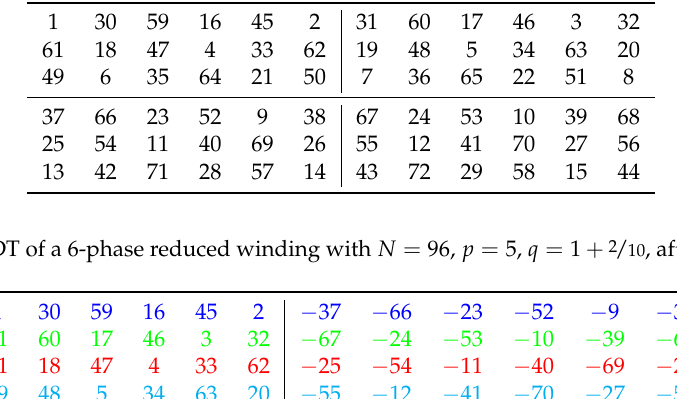
Table 24. WDT of a 6-phase reduced winding with N = 96, p = 5, q = 1 + 2 / 10 .